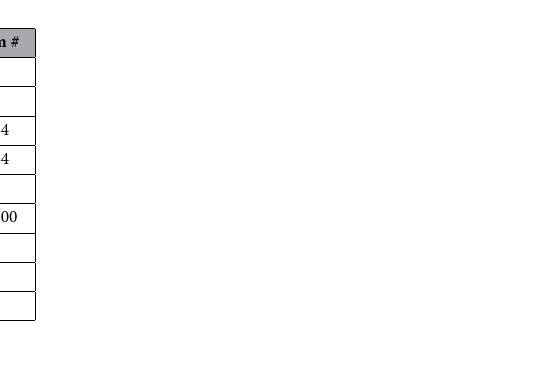
Table 3. The method